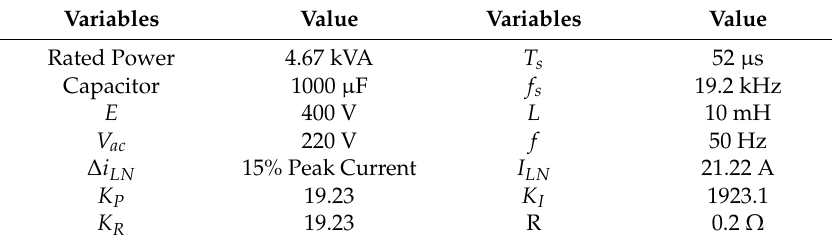
Table 1. Parameters for simulation